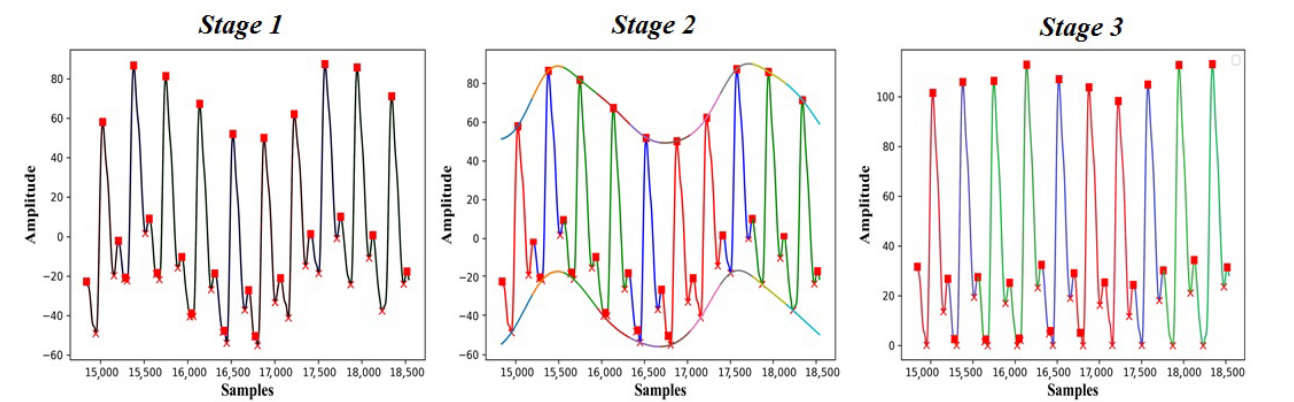
Figure 5. Main stages of removal of signal baseline.